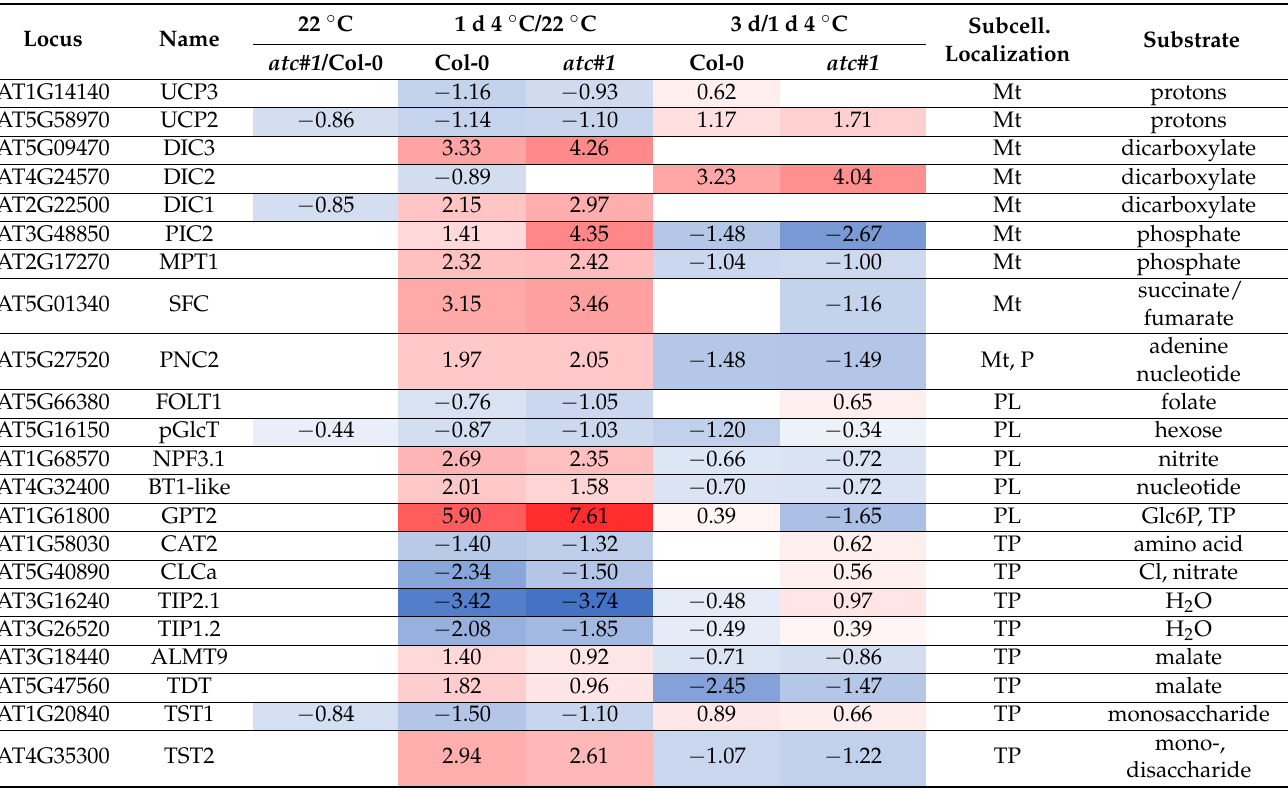
Table 2. DEGs involved in intracellular transport. Selected genes (p adj. < 0.05) are shown. AGI,